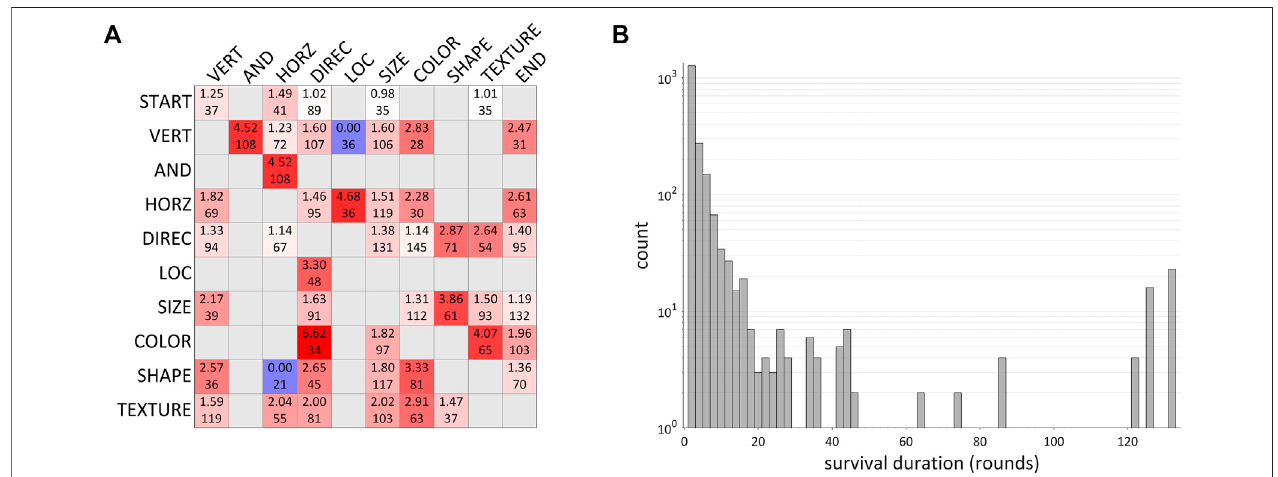
FIGURE 13 | Analysis of interaction effects on Markov chain changes. (A) ratio of percolation rate to adoption rate for occurrences of particular transitions in instruction sequences; number of opportunities for percolation are shown as well. Gray cells are transitions which had fewer than 20 percolation opportunities. (B) histogram of survival durations of states, i.e., number of rounds that use of a transition persisted after being adopted; vertical axis is logarithmic.